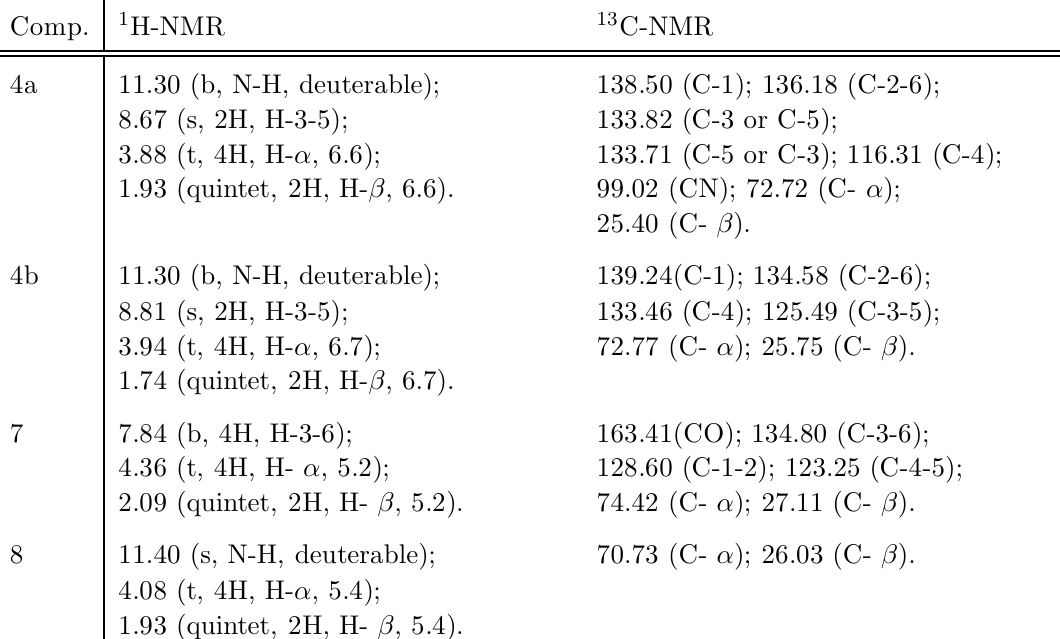
Table 1 NMR spectra of compounds 4a,b, 7 and 8 in DMSO-d 6 : ¯ values, ppm; J